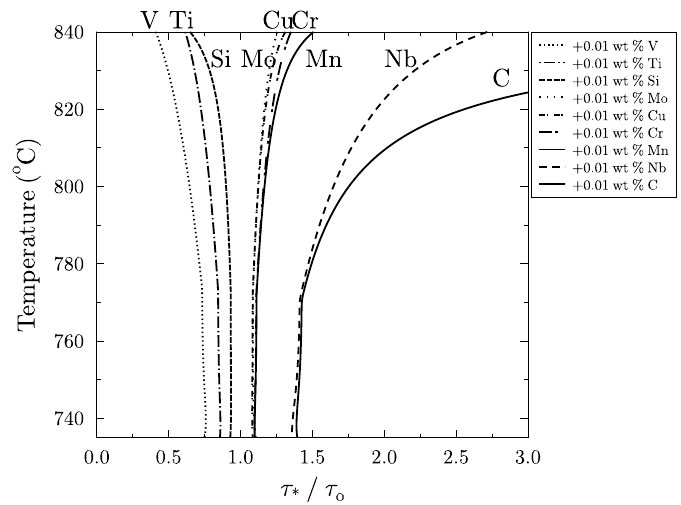
Figure 9. The effects of altering different alloying elements to the phase transformation start at different temperatures for strain hardened steel (deformation schedule b) is shown by calculating the fraction τ ∗ / τ o (see text). The plots are calculated from the difference in the ideal TTT start times for steel “TH16” shown in reference [22] (0.09 C, 0.28 Si, 1.53 Mn, 0.012 P, 0.005 S, 0.03 Al, 0.05 Cr, 0.05 Cu, 0.035 Nb, 0.04 Ni, 0.02 Ti, and 0.05 V wt %).